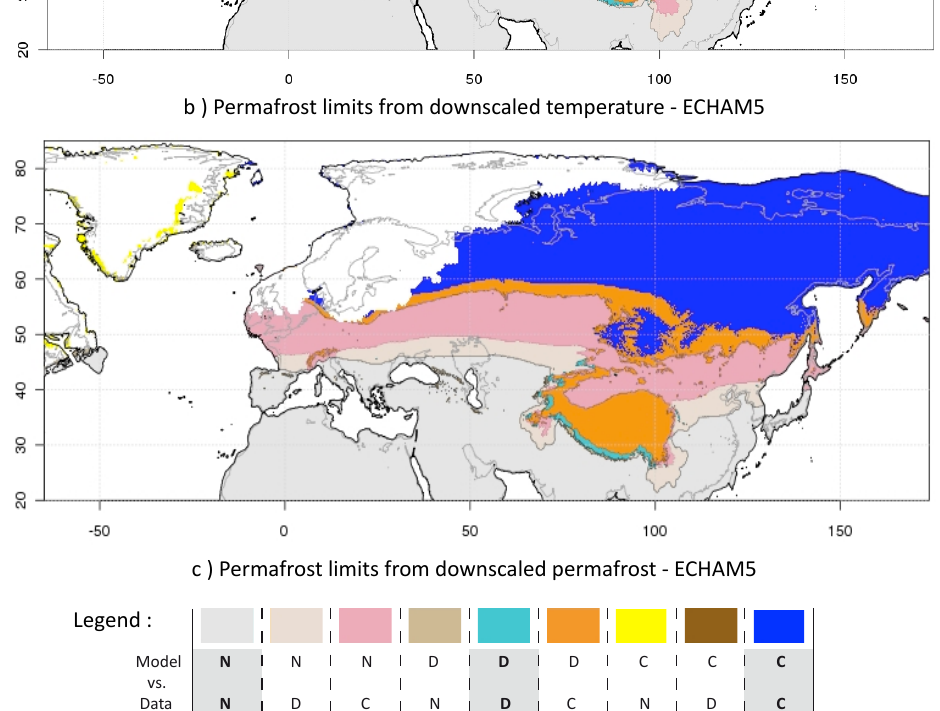
Fig. 7. LGM permafrost comparison between ECHAM5 and the Vandenberghe et al. (2011) permafrost index. (a) Is obtained with a bilinear interpolation of temperatures and the RV conditions to derive permafrost. (b) Is the same from the downscaled temperatures by GAM. (c) Is the downscaled permafrost index by ML-GAM. In the legend panel,“N” corresponds to “No permafrost”, “D” to “Discontinuous permafrost” and “C” to “Continuous permafrost”. The highlighted categories with bold letters show the agreement between model and